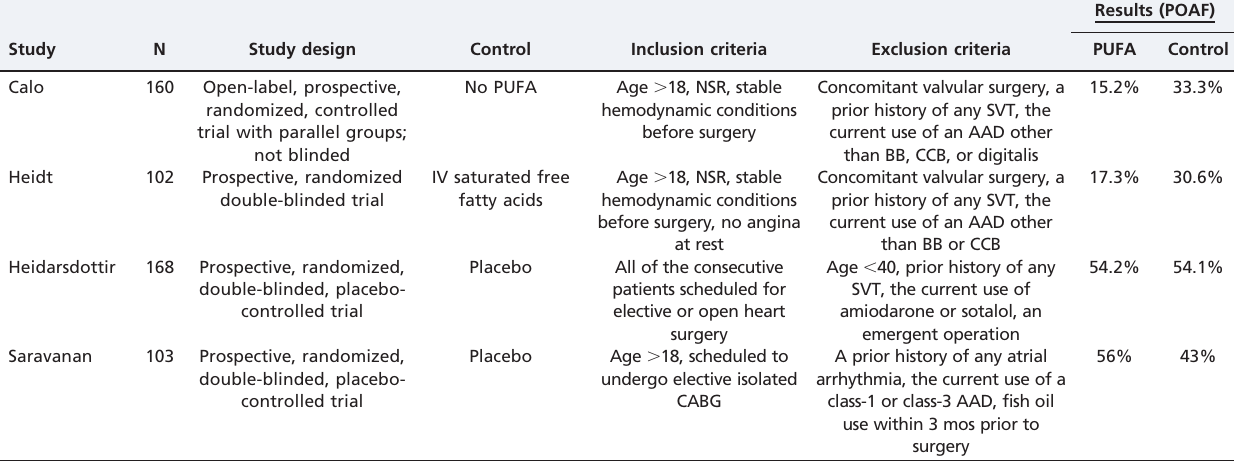
Table 1 - Studies characteristics.